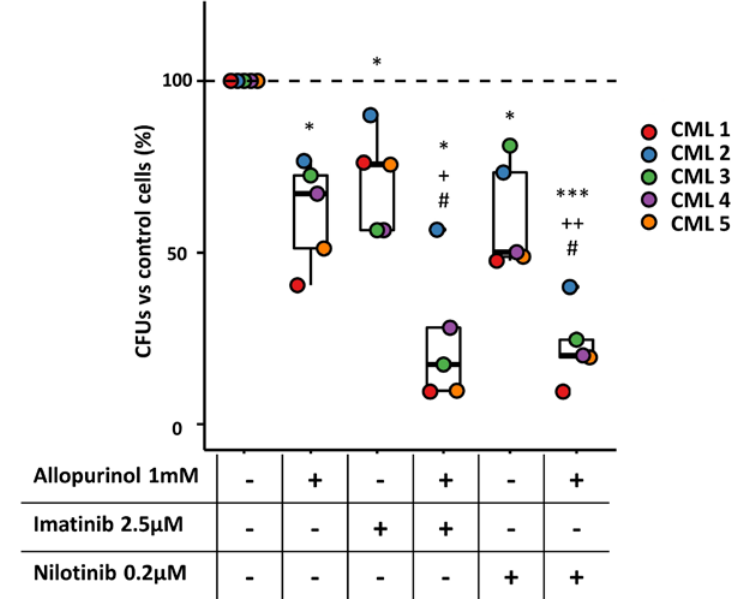
Figure 9. The combination of TKIs and allopurinol reduces the clonogenic capacity of primary chronic myeloid leukemia (CML) cells. BM-MNCs collected from CML patients were treated with TKIs (imatinib and nilotinib), allopurinol, or their combinations for 48 h. The clonogenic capacity after the treatments was analyzed in a semisolid medium by CFU assays. Relative colony numbers of BM-MNCs treated with TKI (imatinib or nilotinib), allopurinol, or their combination are shown. *** p < 0.001, * p < 0.05 with respect to control; ++ p < 0.01, + p < 0.05 with respect allopurinol-treated cells; # p < 0.05 with respect to TKI-treated cells. ( n = 5).